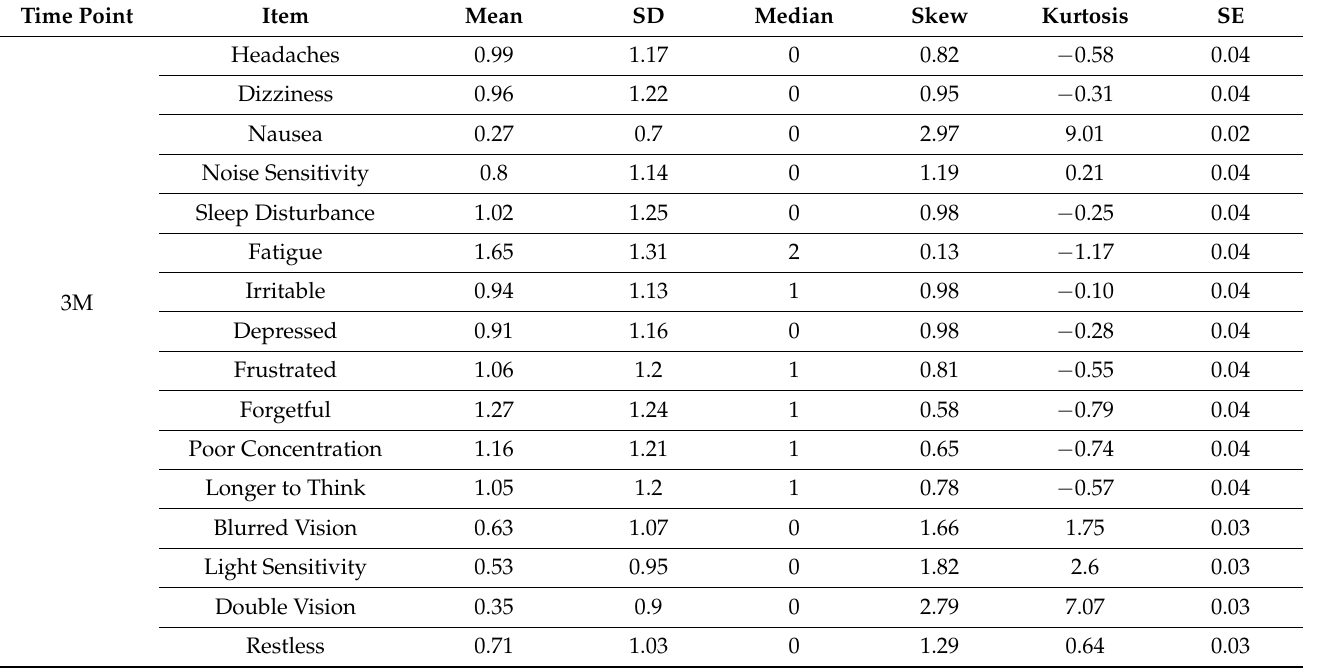
Table A1. Descriptive data analyses by item and time